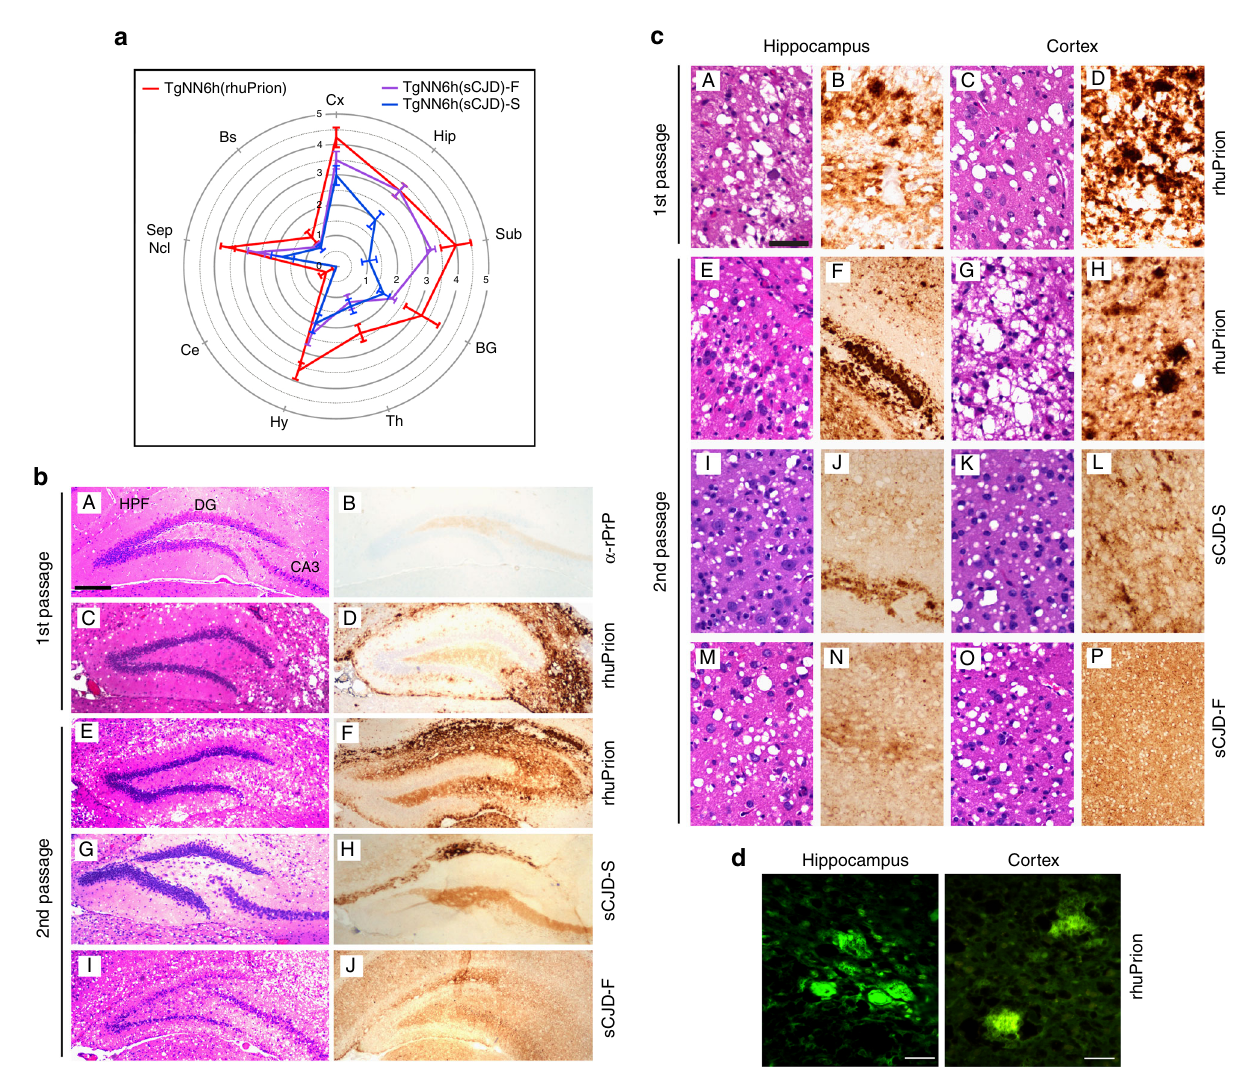
Fig. 3 Neuropathological pro fi les of rhuPrion and sCJD prions in TgNN6h mice. a Semi quantitative vacuolization scoring within the indicated brain regions of rhuPrion and sCJD prions in TgNN6h mice: Cx, cortex; Hip, hippocampus; Sub, subiculum; BG, basal ganglia; Th, thalamus; Hy, hypothalamus; Ce, cerebellum; Sep Nlc, septal nuclei; Bs, brain stem. b Neuropathology panels of hippocampus formation (HPF) of age-matched TgNN6h mice inoculated with alpha-helical monomers of human prion protein ( A , B ), rhuPrion ( C , D ) in the fi rst and ( E , F ) second passage; panels G , H , I , J show distinct characteristics of second passage of sCJD-S and sCJD-F prions. c Extensive neuronal loss and vacuolization in the CA3 pyramidal layer of hippocampus ( A ) and in the cortex ( C ) in the ( fi rst ( A , C )) and second ( E , G ) passage of rhuPrion in contrast to less prominent loss in TgNN6h mice inoculated with sCJD-S ( I , K ) and sCJD-F ( M , O ) prions as visualized by H&E staining. Extensive PrP Sc depositions in the stratum oriens of CA1 hypocampal formation and cortex following fi rst ( B , D ) or second ( F , H ) passage of rhuPrions. Distinctly different patterns of depositions of PrP Sc in sCJD-S and sCJD-F prions in both hippocampus ( J , N ) and cortex ( L , P ) of TgNN6h mice. d Thio fl avin S positive amyloid plaques in the hippocampus and cortex of TgNN6h mice inoculated with rhuPrion. Vacuolization was visualized by H&E staining, and PrPSc deposition was assessed by immunohistochemistry with the antibody 3F4. HPF, Hippocampus formation; DG, granule cell layer of the dentate gyrus; CA3, pyramidal layer of